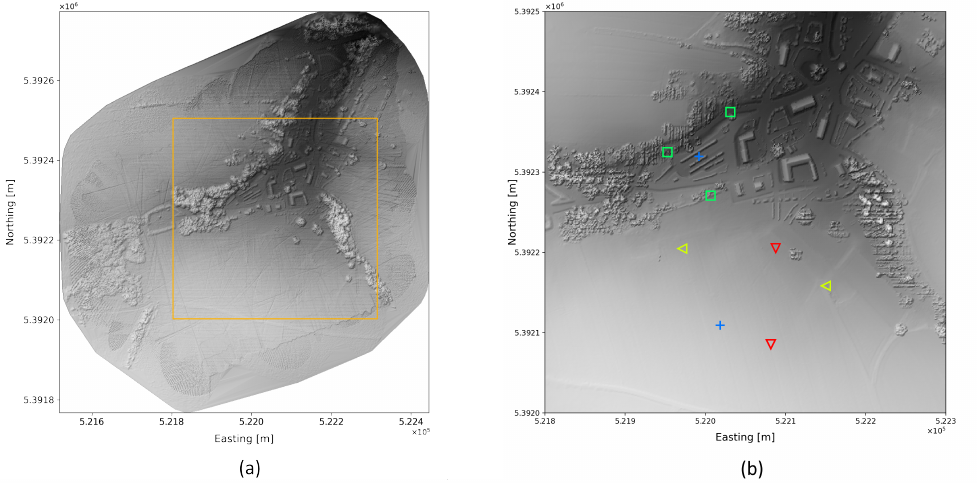
Figure 5. Projection of LiDAR points of the test area ( a ). Position of the radioactive sources during test flights ( b ) for flights 1–5 (red triangle), flights 6–12 (yellow triangle), flights 13–22 (green squares), and flights 23–28 (blue